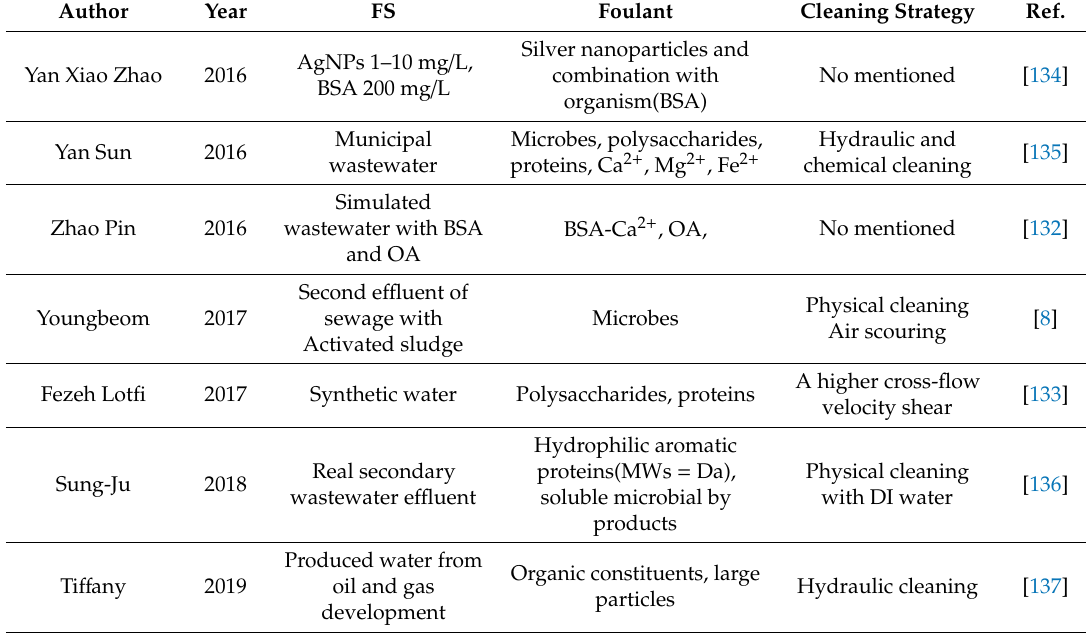
Table 6. Listed the main foulant in membrane fouling of the FO process system and the cleaning strategies in recently